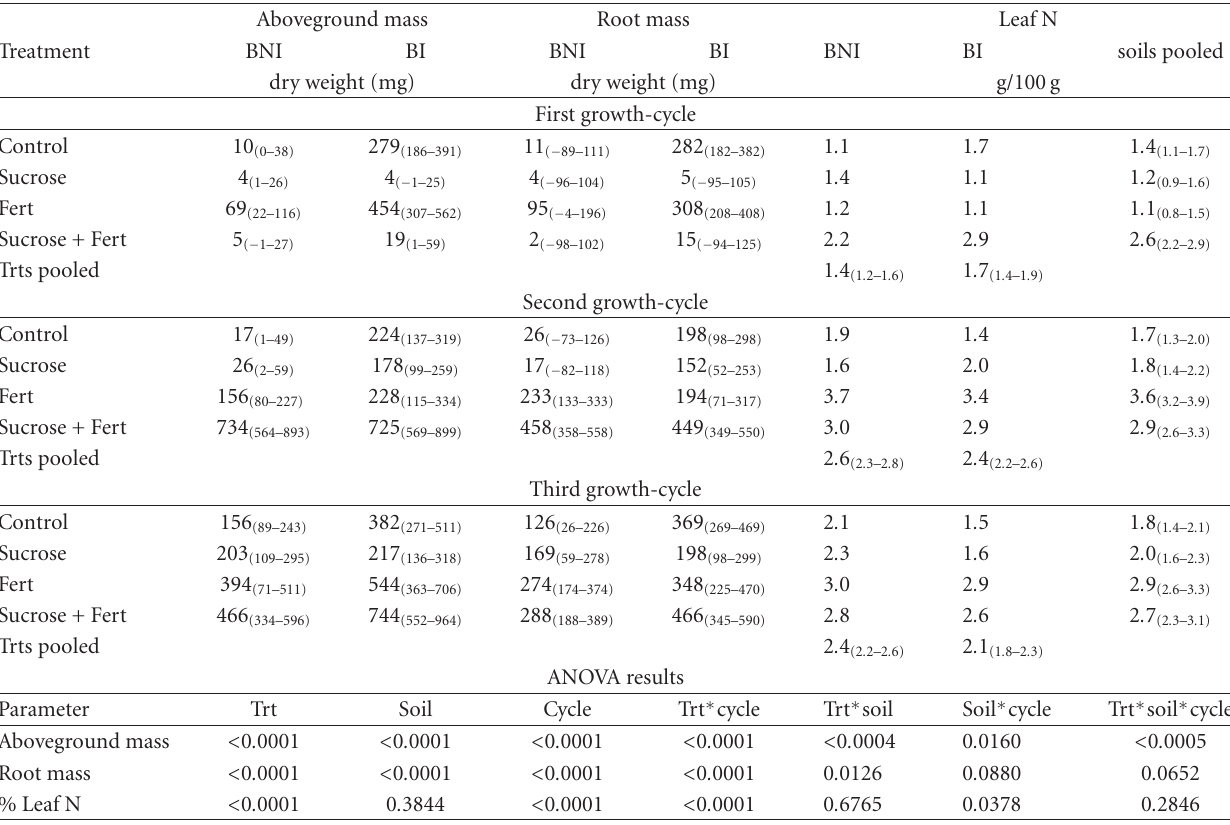
Table 3: Influence of treatment, soil invasion status, and growth-cycle on B. tectorum growth and leaf N